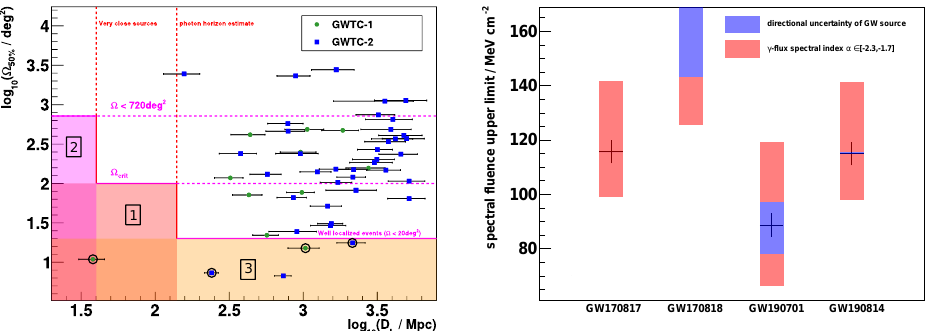
Figure 8. ( Left ) The three classes of selected gravitational wave sources in the follow-up search for photons in association with gravitational wave events, as defined by their 50% localization region ( Ω 50% ) and luminosity distance ( D L ); the circled markers in the acceptance region mark the events which had at least some overlap with the field of view of the SD at any time. ( Right ) Preliminary upper limits on the spectral fluence of UHE photons at Earth for each of the selected gravitational wave sources; the uncertainty bars include both the directional uncertainty of the gravitational wave event (blue) and the uncertainty due to the choice of the spectral index used to calculate the spectral fluence (red); for the second event, the uncertainty bars extend beyond the plotted range, since this source is located right at the edge of the field of view of the Pierre Auger Observatory. For more details, see